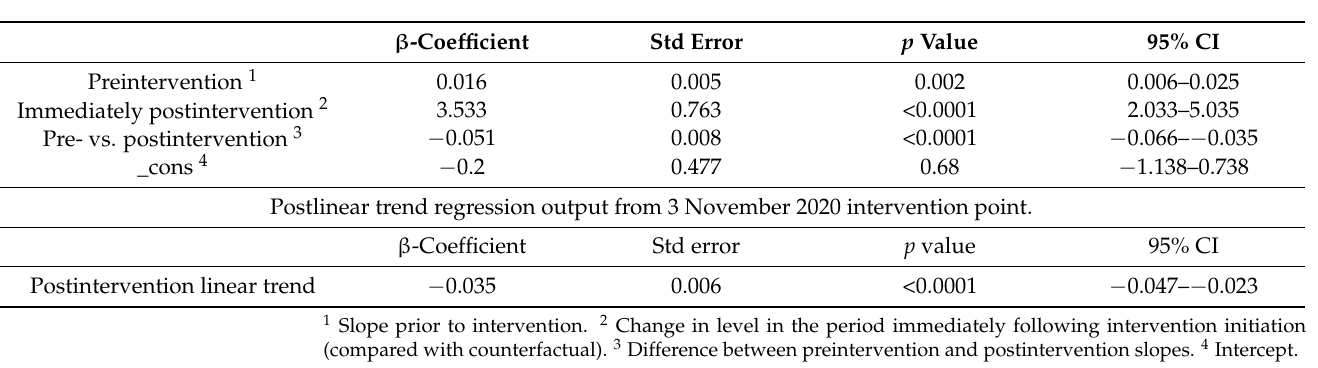
Table 5. Interrupted time series ordinary least-squares regression output at 3 November 2020